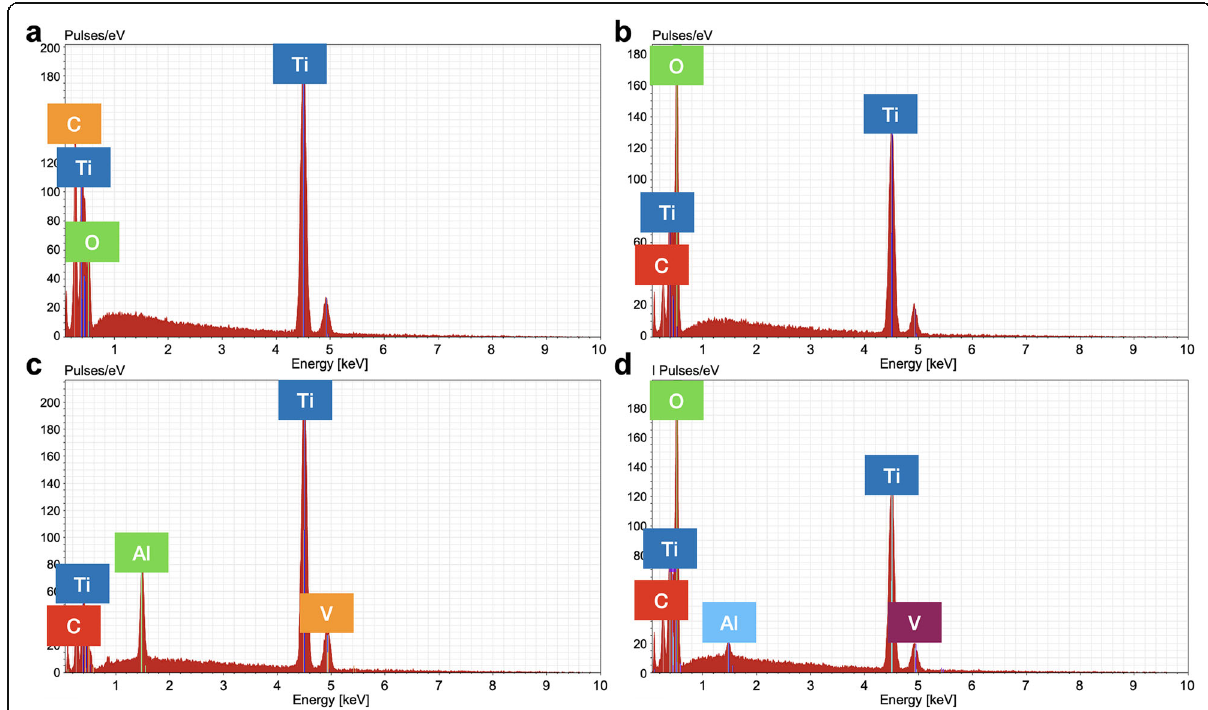
Fig. 2 EDX spectra of particles produced by the mock implantoplasty procedure (SEM images in Fig. 1). a , b Particles from grade 4 commercially pure titanium implant, a angular microparticles and b small spheres. c , d particles from grade 5 titanium alloy, c angular microparticles and d small spheres (grade